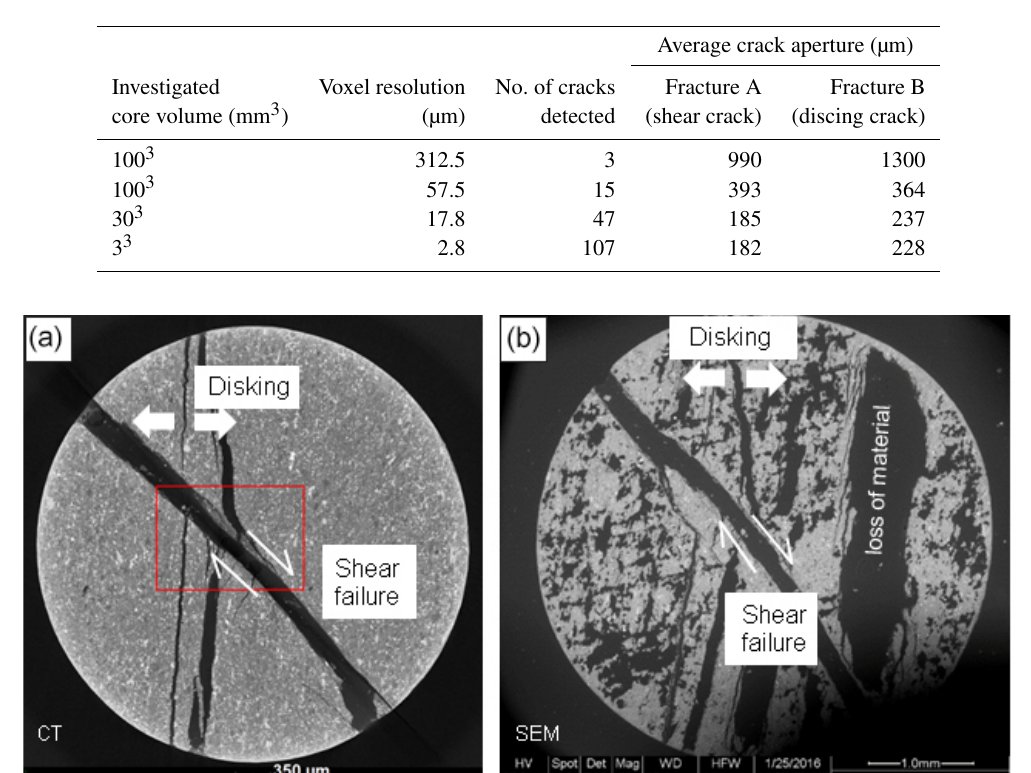
Table 1. Comparison of sample size and image resolution related fracture detection and geometrical fracture analysis results for the two main cracks observed.